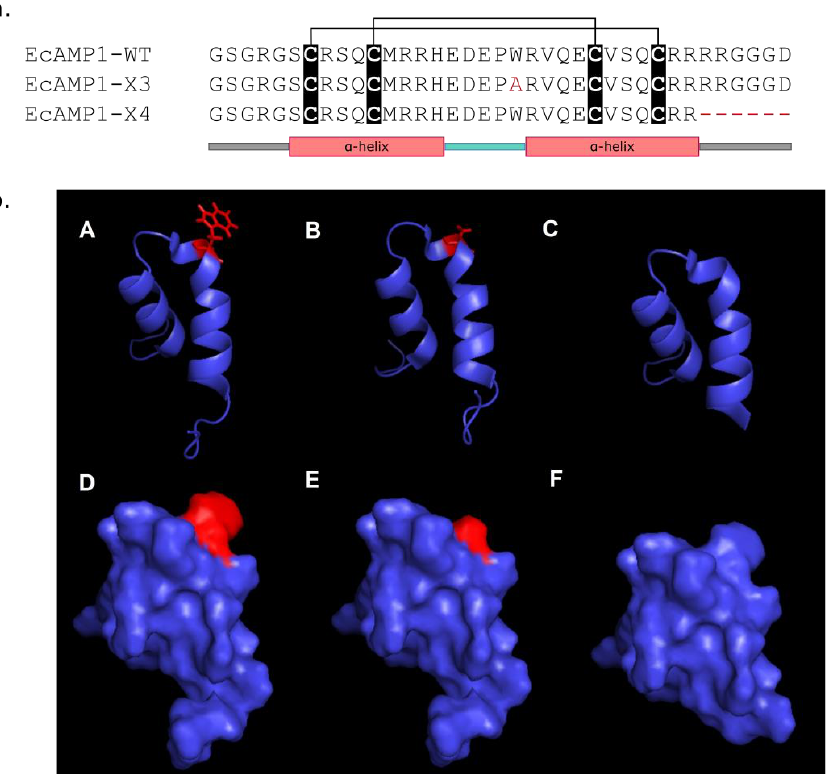
Figure 2. Structures of the wild-type EcAMP1 and its recombinant analogs EcAMP1-X3 and EcAMP1-X4. ( a ) Amino acid sequences of peptides compared to a schematic view of α -hairpinin secondary structure. Cys residues are shown in black boxes, and disulfide bridges are shown as black lines above. EcAMP1-X3 sequence Ala that substituted Trp 20 is marked in red. EcAMP1-X4 lacking C-terminal residues are marked by red gaps. ( b ) 3D modeling of wild-type EcAMP1 and its modified recombinant analogs. A–C ribbon models and D–F surface models. Wild-type EcAMP1-WT ( A , D ); EcAMP1-X3 ( B , E ); and EcAMP1-X4 ( C , F ). Trp20 in EcAMP1-WT and Ala20 in EcAMP-X3 are shown in